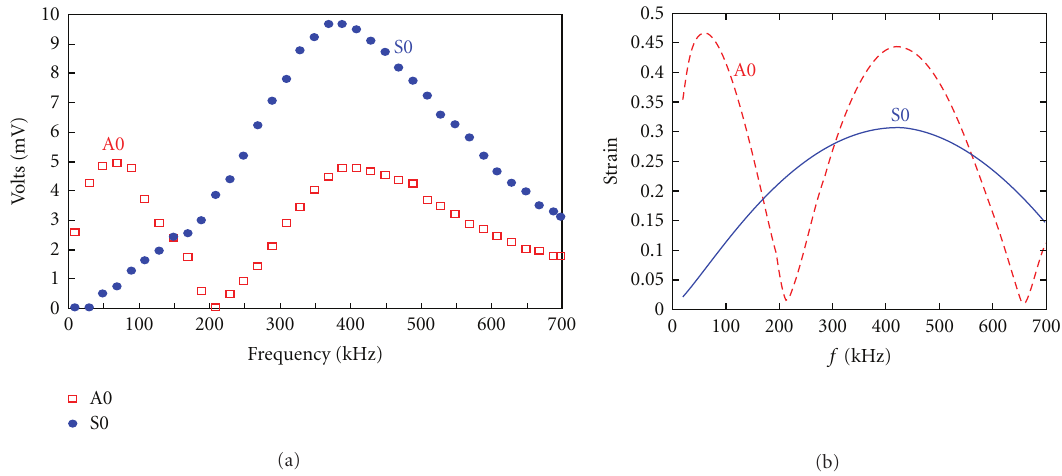
Figure 2: Lamb wave mode tuning on a 1-mm thick aluminum alloy 2024-T3 using 7-mm PWAS. (a) Experimental wave amplitude within 0 ∼ 700 kHz; (b) predicted strain curves [13].